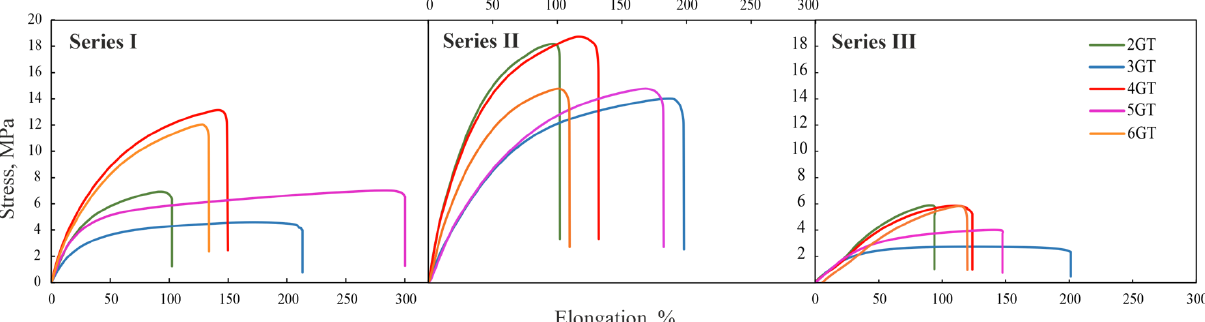
Figure 15. Strain–stress curves of TPEs.